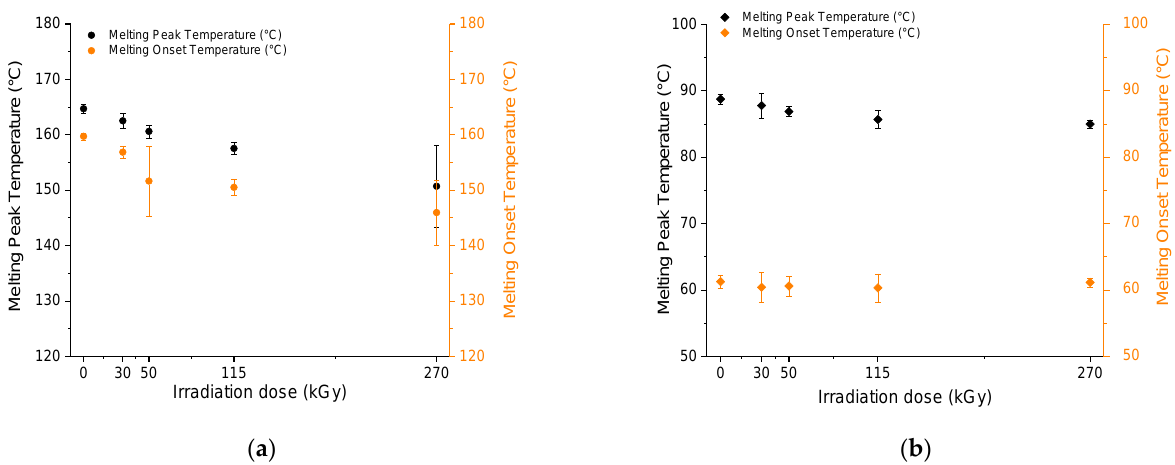
Figure 11. Melting peaks and melting onset points for the EVOH layer ( a ) and the EVA layer ( b ) used in the EVA/EVOH/EVA multilayer film according to the γ-irradiation dose. Reproduced from [34] with the permission of Journal of Applied Polymer Science.